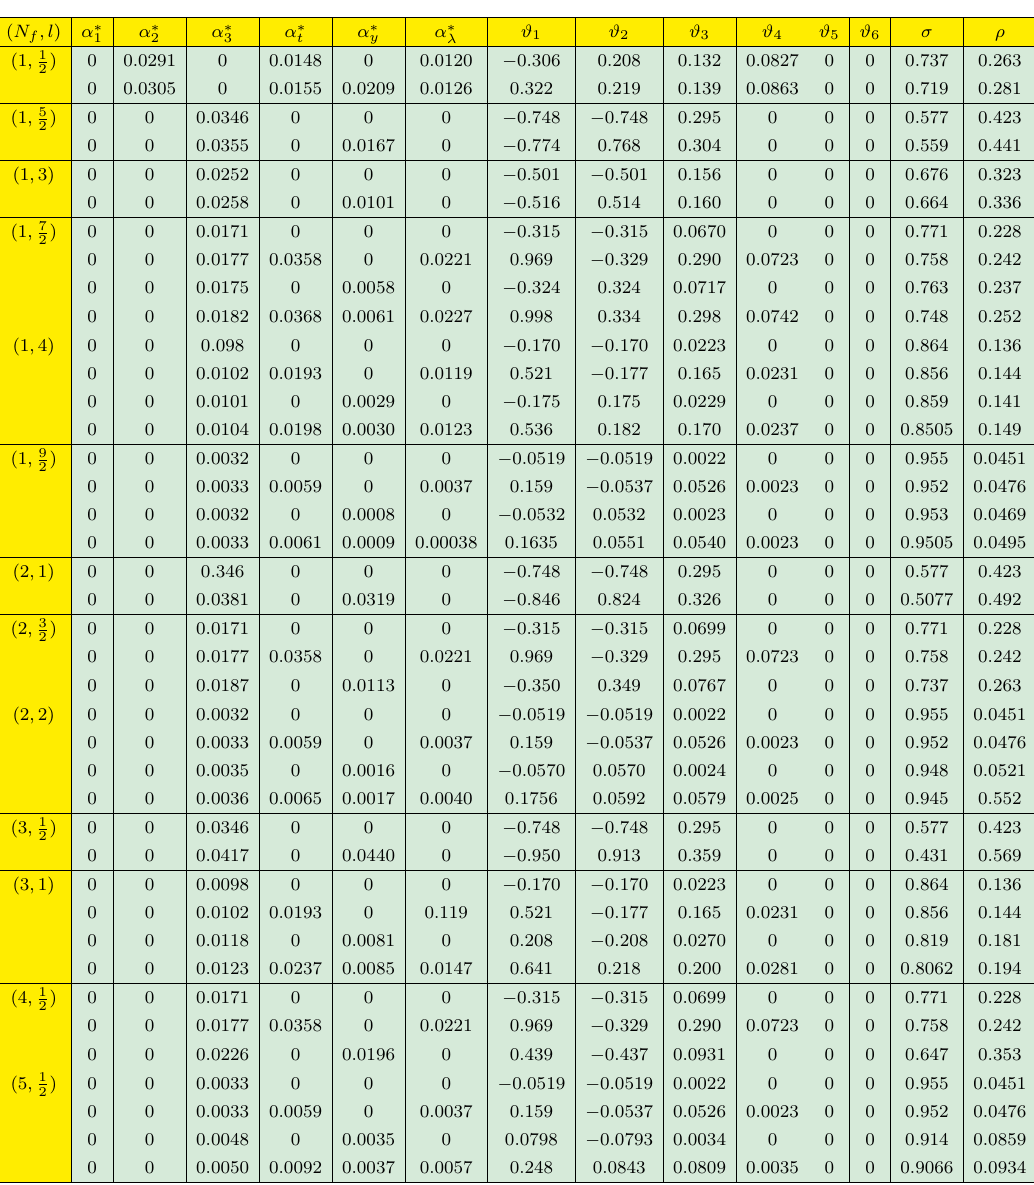
Table 7 . Fixed points and eigenvalues for vector-like fermions in the fundamental representation of SU c (3), in the 321 approximation scheme. The last two columns give the values of the ratio (cid:27) and (cid:26) for (cid:11) or (cid:11) depending on the case (see 2.15). 2 3